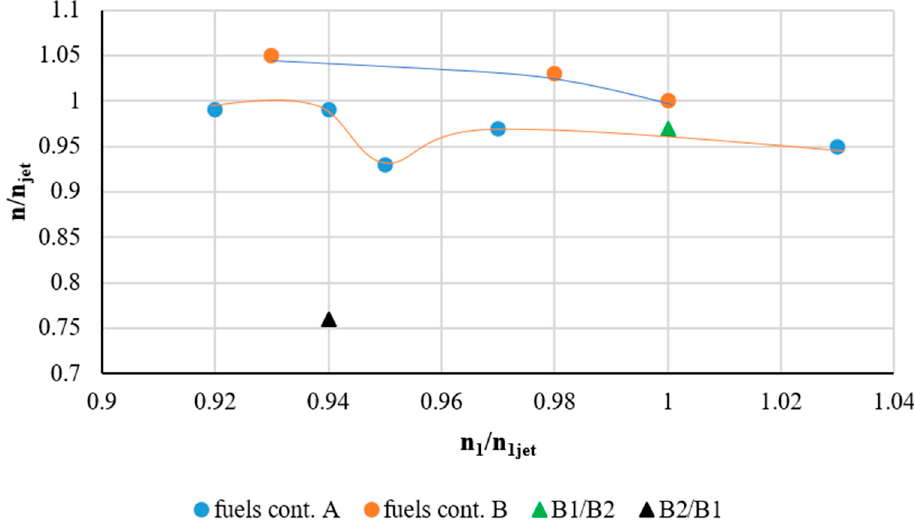
Figure 13. Relationship between n/n 1jet and n 1 /n 11jet values (relationship between the criteria of similarity for the combustion process sequence, based on measuring CO content in exhaust gases and combustion chamber temperature gradient (T 3max − T 2 ) / (T 3min − T 2 )).